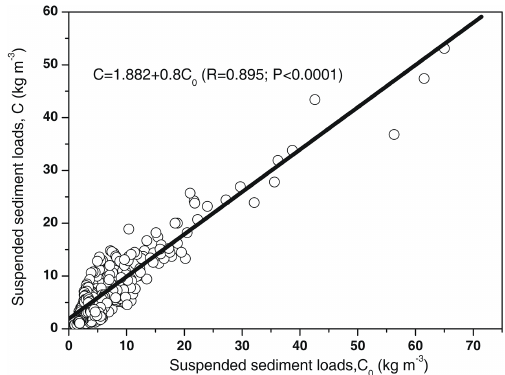
Figure 11. Relation of suspended sediment loads monitored in the Shizuishan gauge (C0) and the Bayangaole gauge